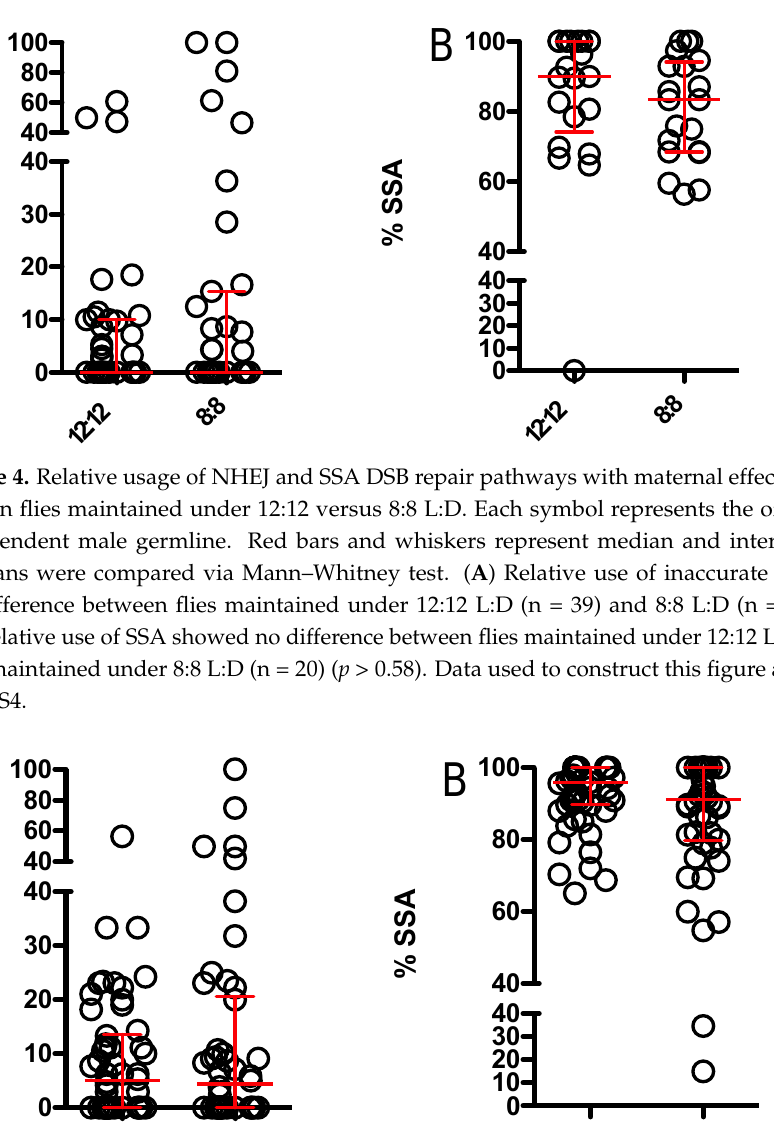
cropped to remove the microscope objective edges visible at the border of the image.